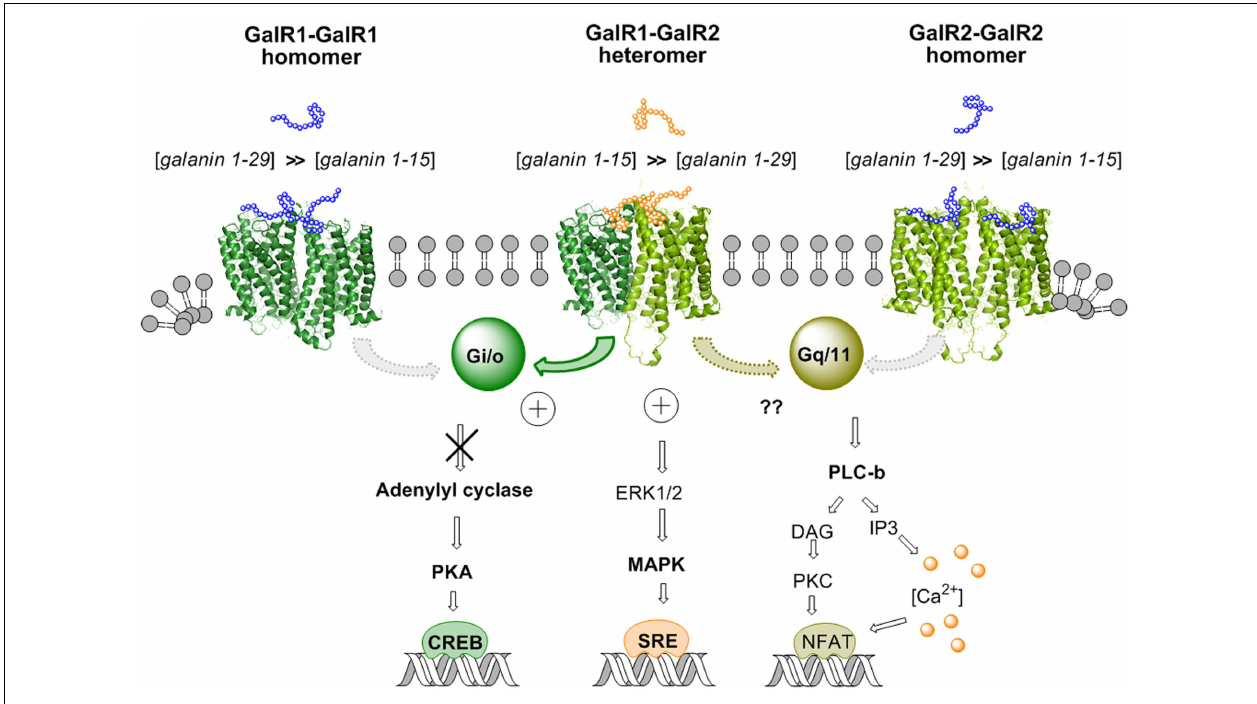
activity in the AC–PKA–CREB pathway and increase activity in the MAPK–SRE pathway in cotransfected GalR1 and GalR2 HEK cells vs. GalR1 and GalR2 singly transfected cells.The activity of the GalR2 protomer in the Gq/11–PLC pathway of the GalR–GalR2 heteromer remains to be